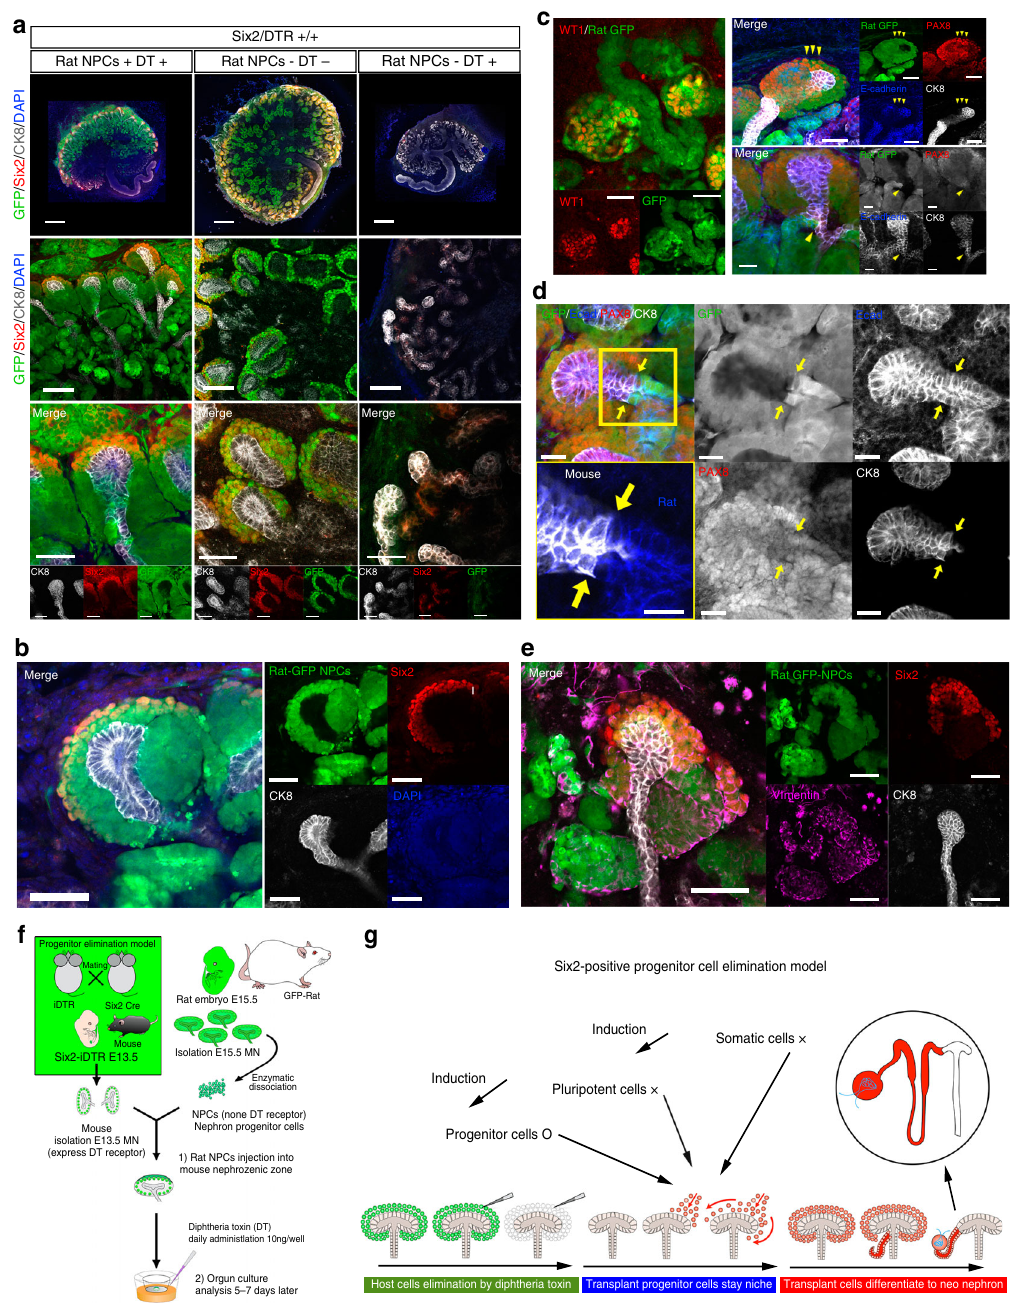
Host cells elimination by diphtheria toxin Transplant progenitor cells stay niche Transplant cells differentiate to neo nephron